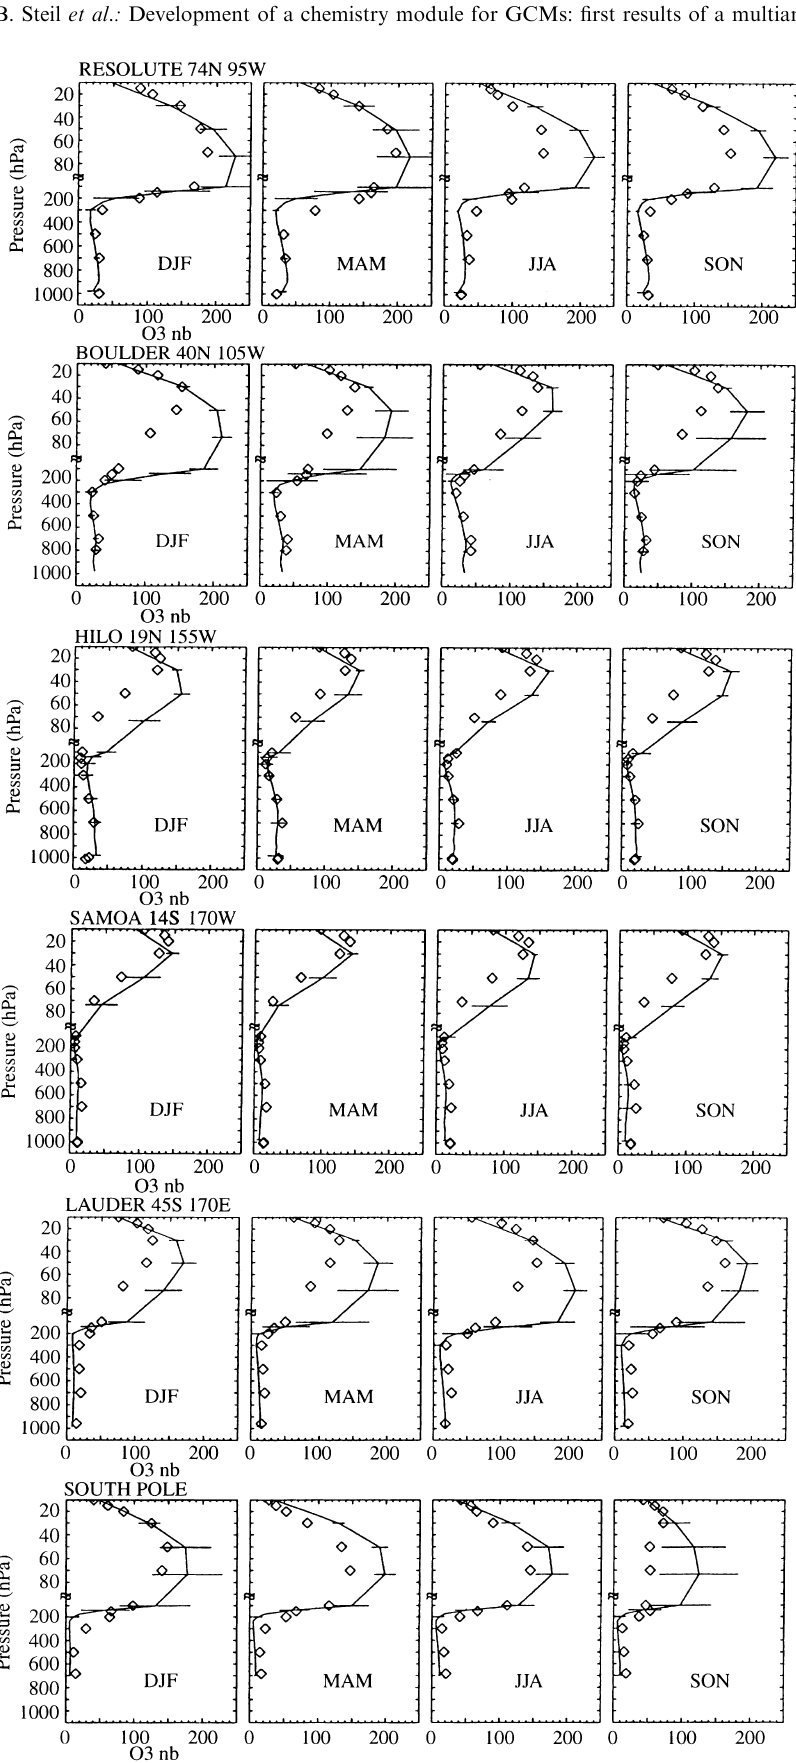
Fig. 4. Intercomparison of measured and simulated mean ozone profiles at di(cid:128)erent locations: measurements represent the mean state during the second half of the eighties; simulations represent the results of model years 5–15 at corresponding grid points (see text). Diamonds indicate data based on obser- vations, horizontal bars the 2 (cid:114) variability of model output. Time-averages are for the four seasons DJF, MAM, JJA and SON, respec- tively; units are